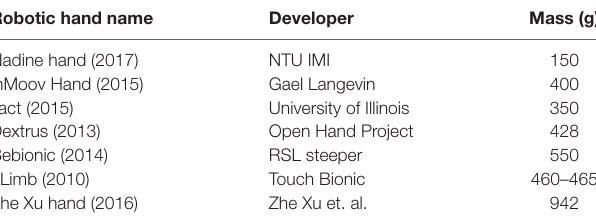
TaBle 2 | Mass of the robotic